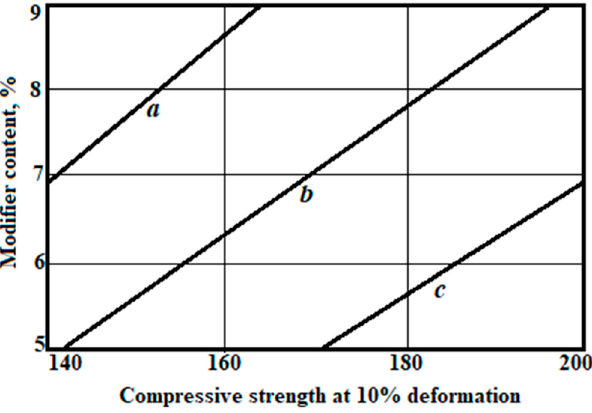
Figure 7. Dependence of compressive strength at the 10% deformation of polyethylene foam samples, with the content of recycled polyethylene content: a—10 kg/m 3 ; b—20 kg/m 3 ; c—30 kg/m 3 .